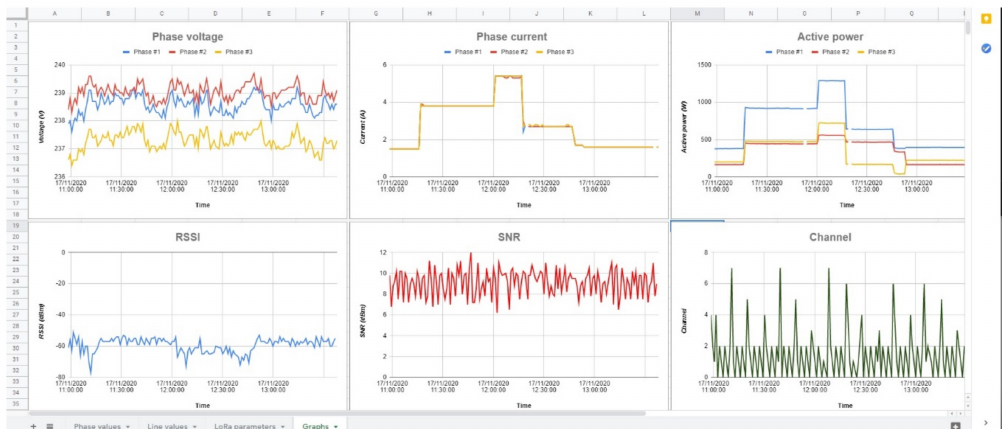
Figure 26. Data uploaded to TTN and sent to Google